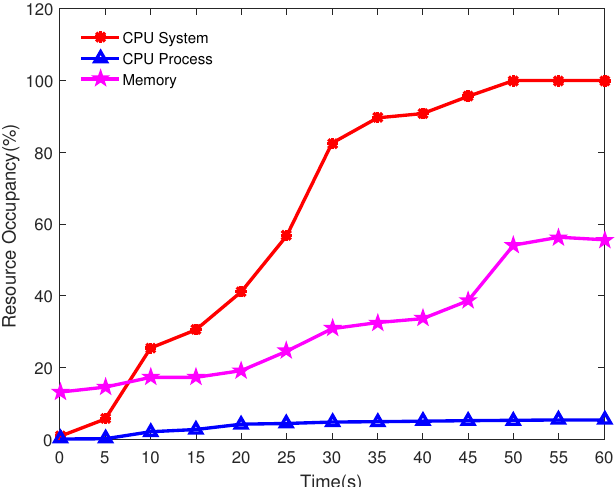
Figure 6. Graph of Changes in CPU, Memory, etc. During Network